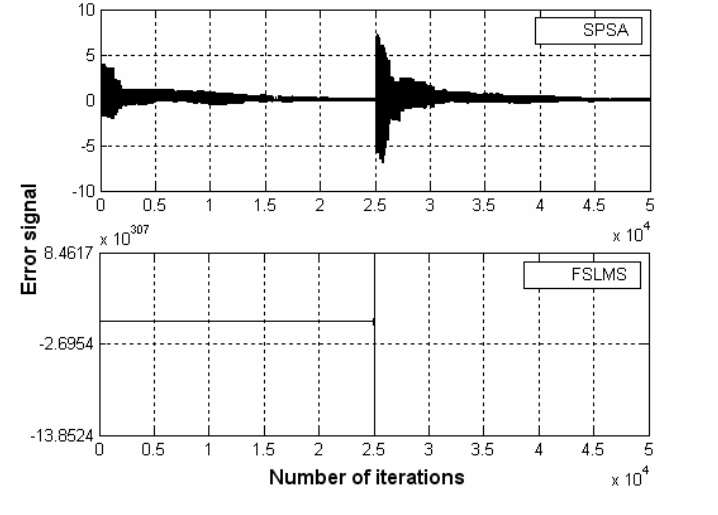
Fig. 7. The error signal versus number of iterations for case